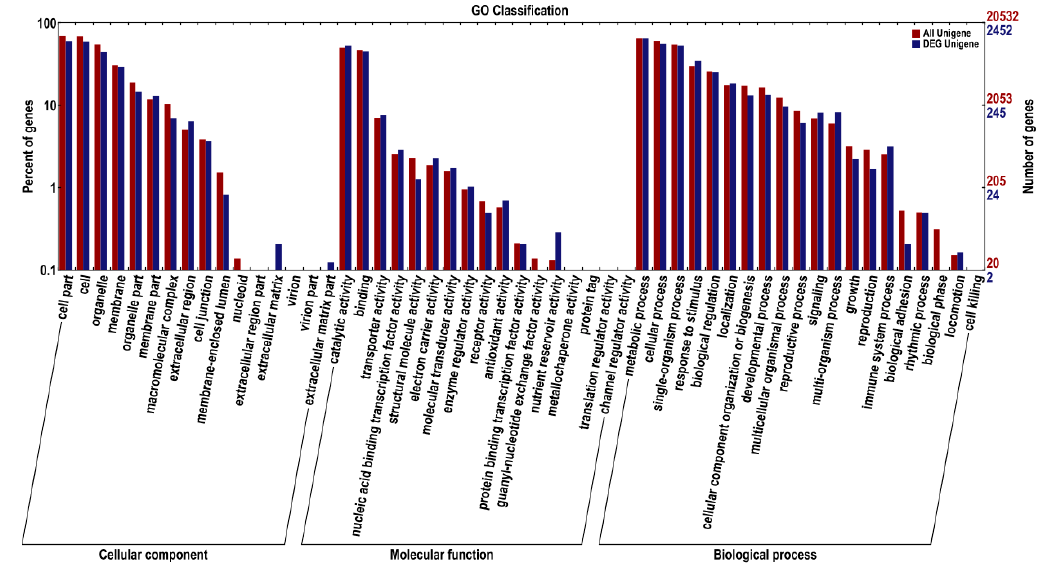
Figure 3. Functional gene ontology (GO) term classifications of DEGs from comparisons of WT and MT plants.